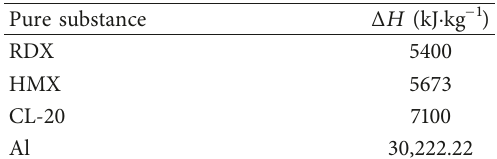
Figure 4: Thermal conductivity of the three groups of samples (testing temperature was 25 ° C). Table 2: Standard exothermic enthalpy of pure substances.